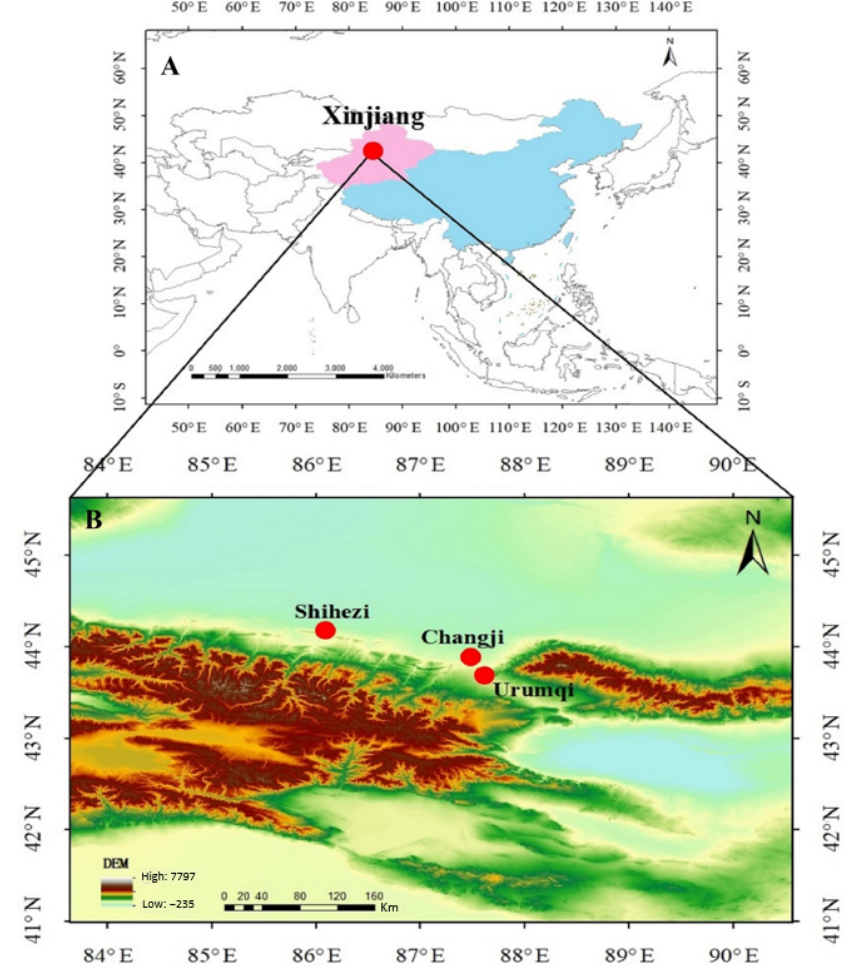
Figure 1. ( a ) Concept of the proposed force plate. This force plate consists of a planar spring and an Figure 1. Wu-Chang-Shi urban. ( A ) Geography, ( B ) Topography. eddy current displacement sensor. ( b ) Side view of the proposed force plate. Table 1. Summary statistics for the six criteria pollutants and AQI in the Wu-chang-shi urban for 2017–2021. ( µ g m − 3